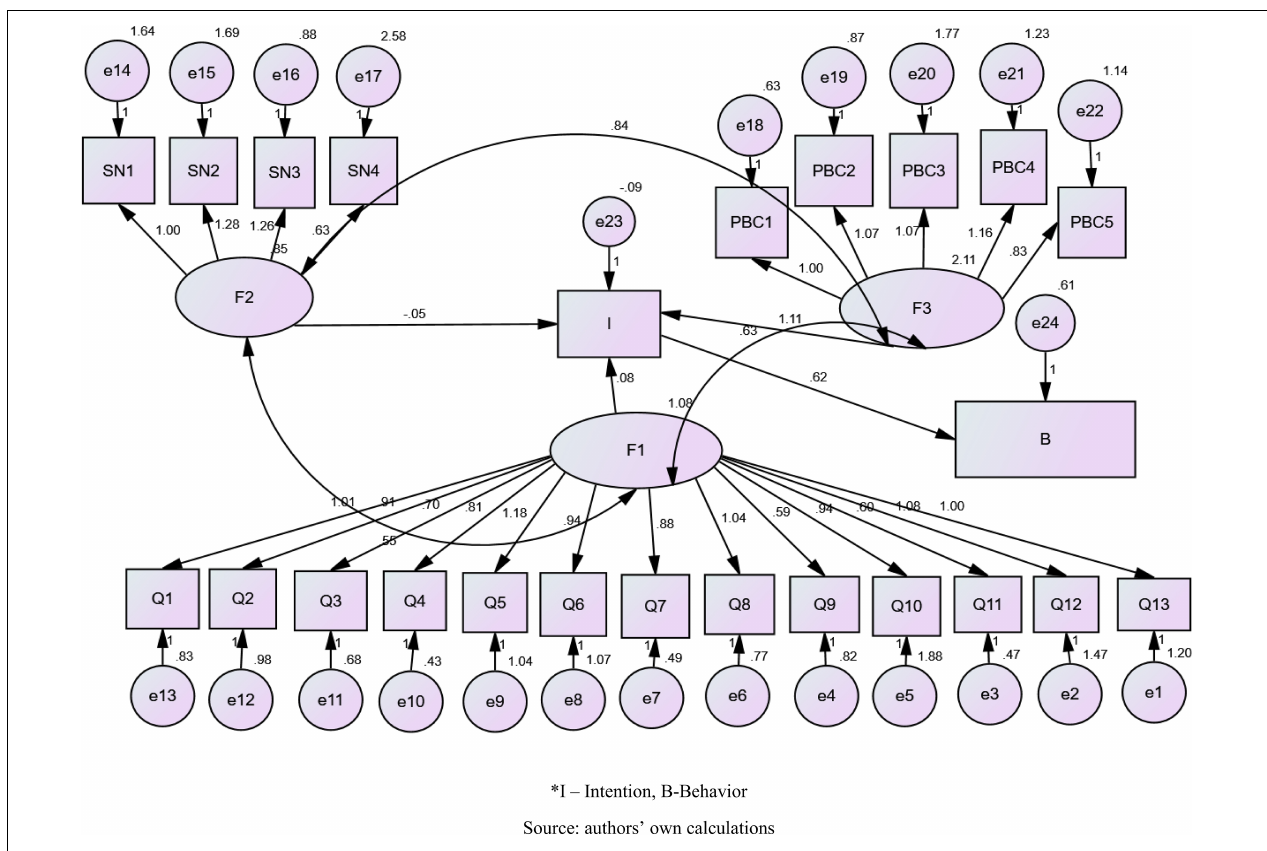
FIGURE 2 | Standardized path coefficients. *I, intention; B, behavior. Source: authors’ own